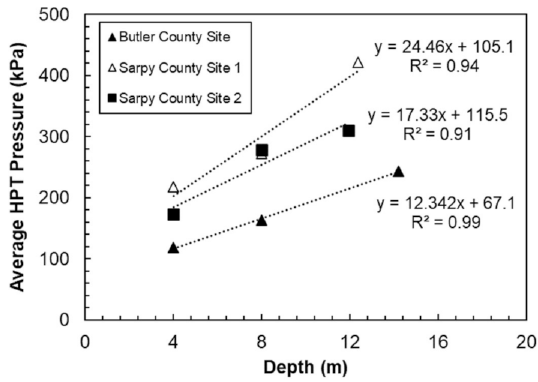
Figure 7. Average HPT pressures with